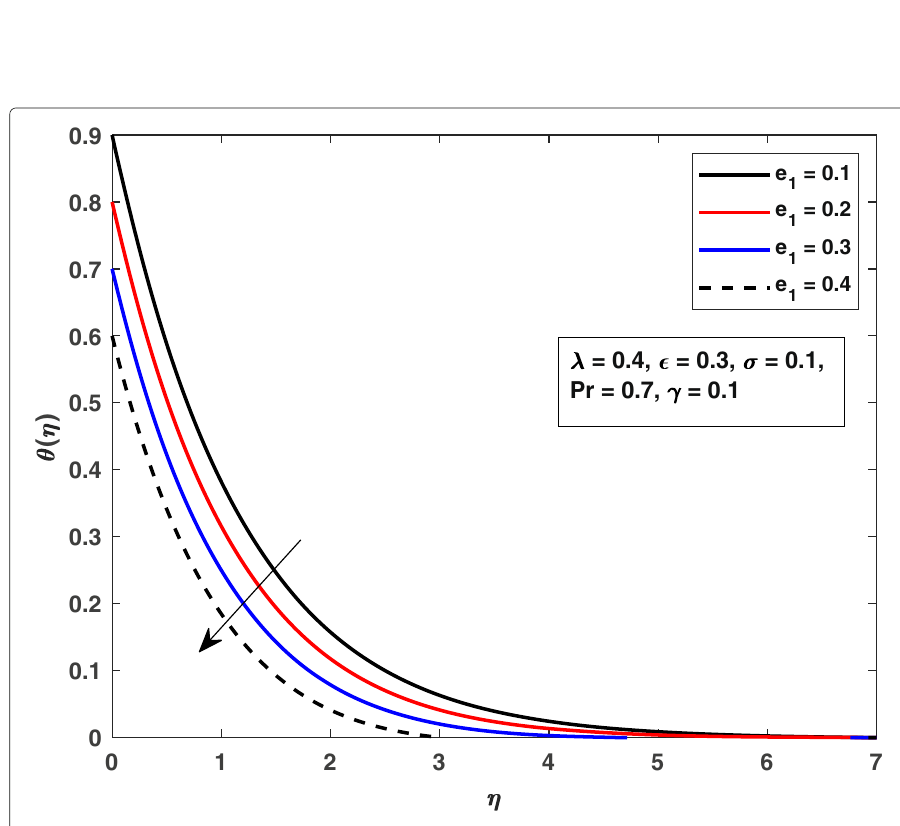
Fig. 11 Impact of the thermal stratification parameter e 1 on